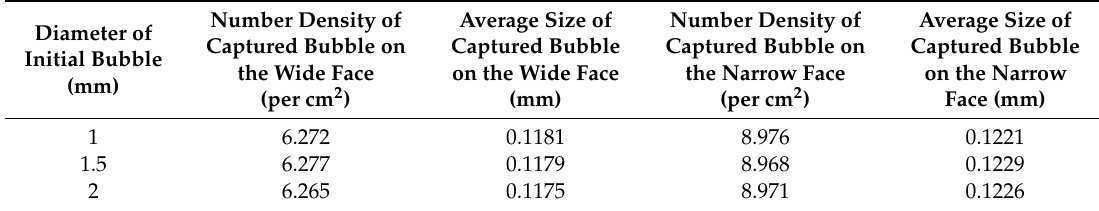
Table 5. Captured bubble distribution with di ff erent initial bubble sizes at the operation casting speed of 1.7 m / min and gas flow rate of 8.2% gas volume